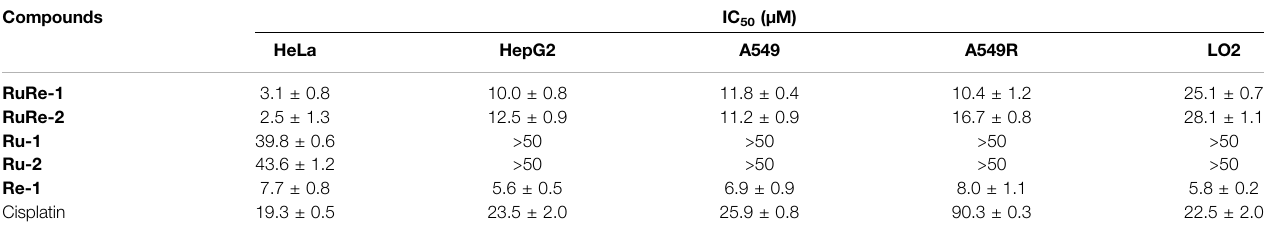
TABLE 1 | IC 50 values of tested compounds towards different cell lines a . Compounds